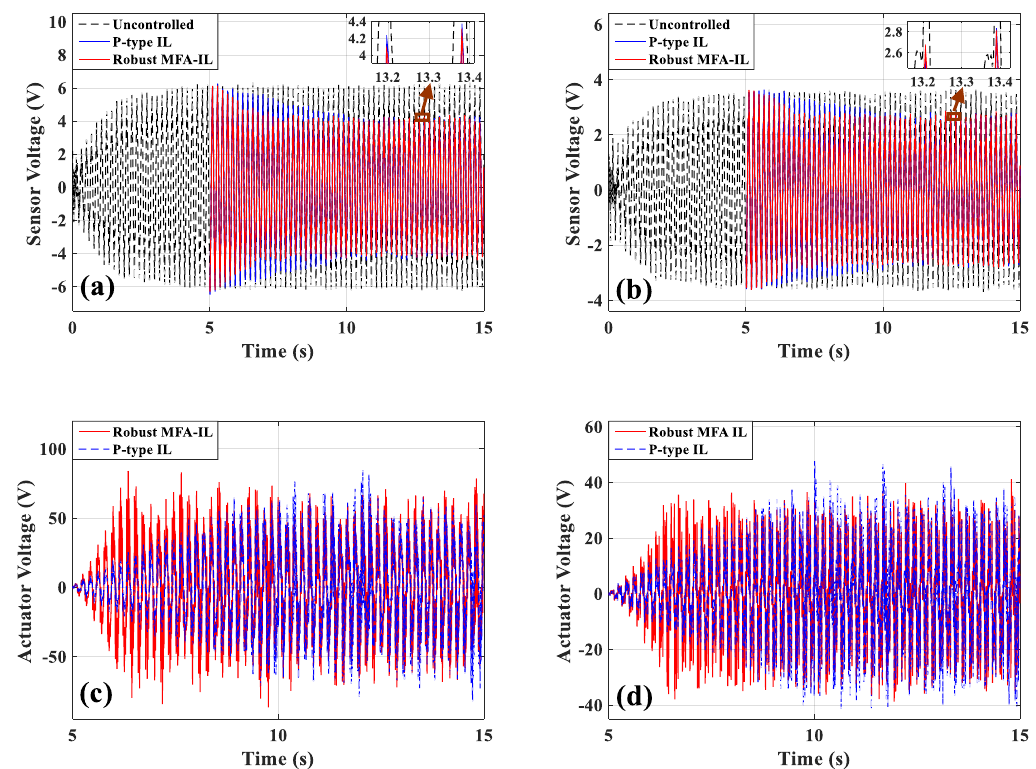
Figure 19. The time-domain response of actuators/sensors: ( a ) Actuators a / b , ( b ) actuator c , ( c ) sensors a / b , ( d ) sensor c .